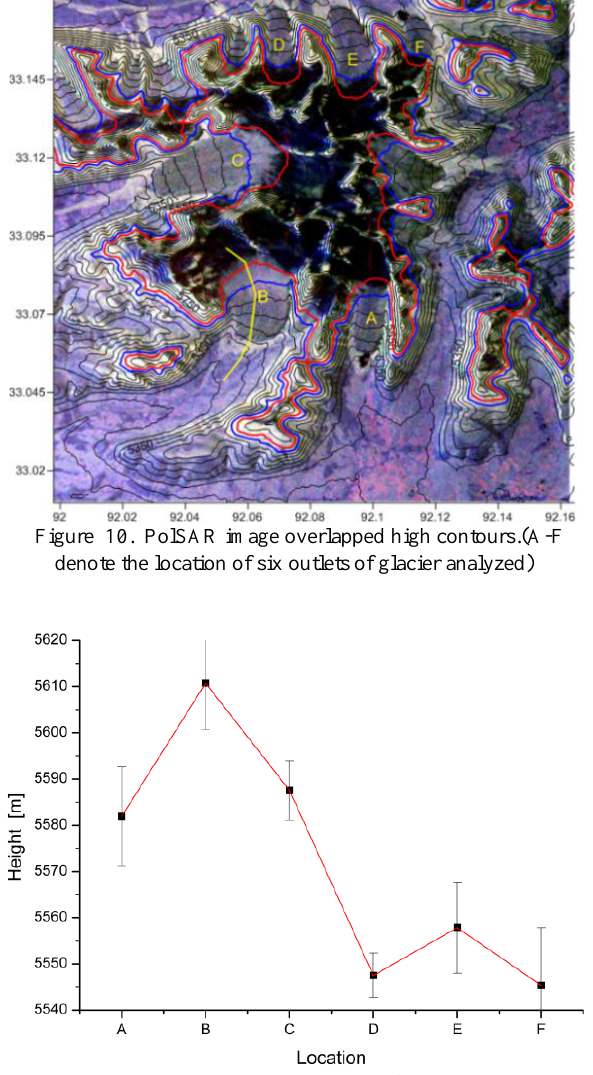
Figure 11. Comparison these altitudes of wet snow lines in Dongkemadi